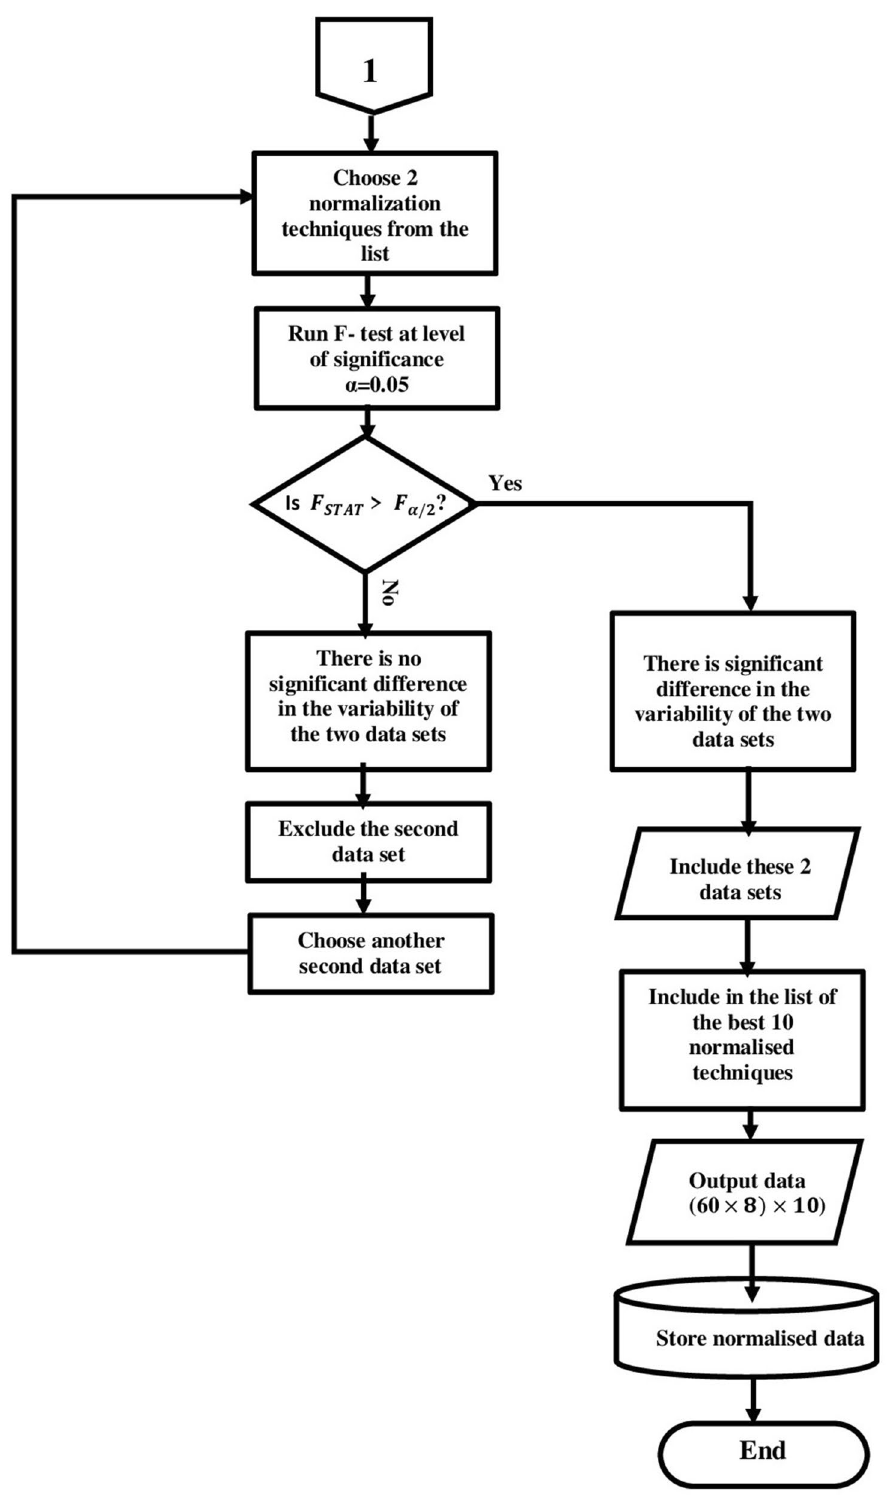
Figure 6. Statistical analysis sequence flow chart (Part